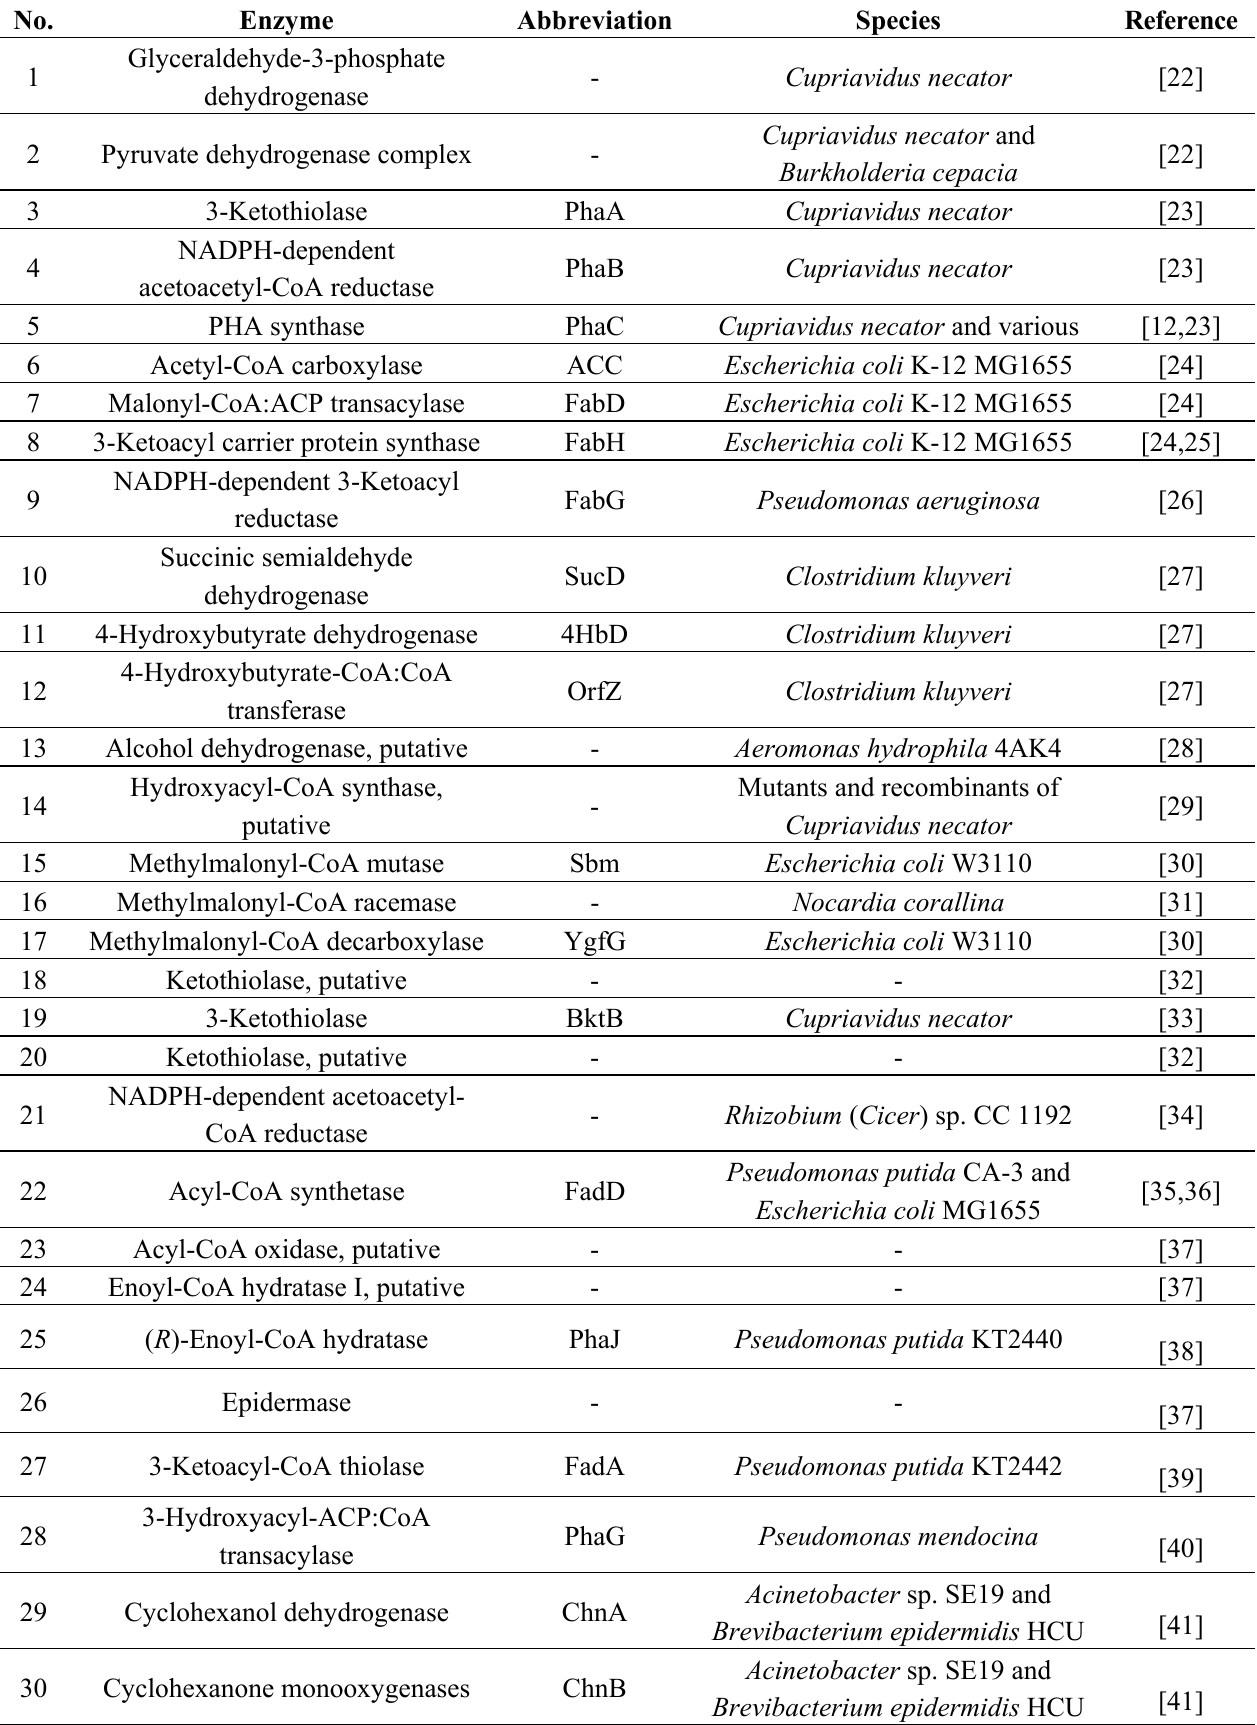
Table 1. Enzymes involved in PHA biosynthesis